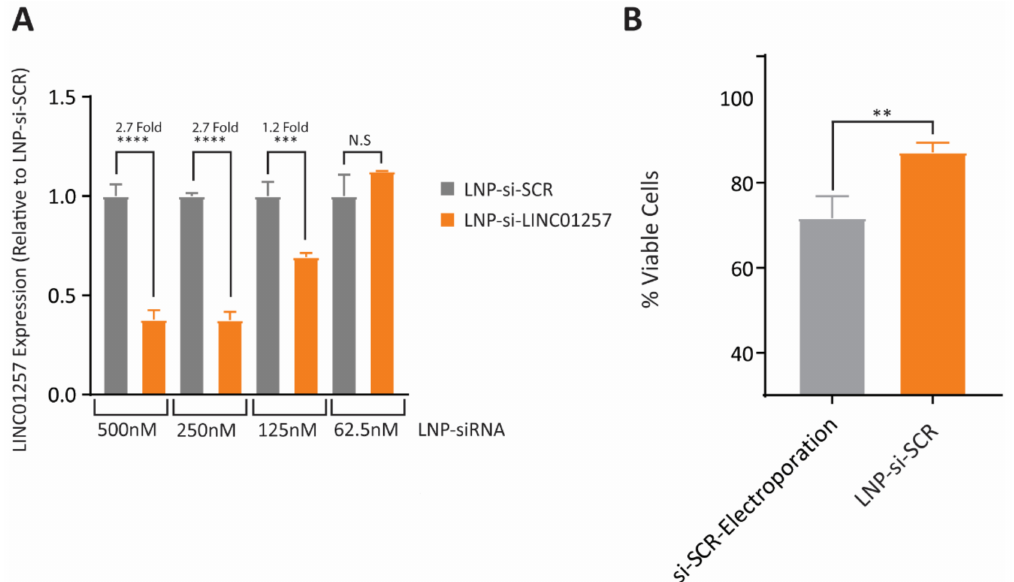
Figure 5. LNP-siRNAs can effectively target LINC01257 in Kasumi-1 cells. ( A ) RT-qPCR of LINC01257 expression following 72 h treatment with LNP-si-SCR at varying concentrations. **** = p < 0.0001, *** = p < 0.001, N.S = no significance. n = 3. ( B ) Viability of Kasumi-1 cells following either electroporation with si-SCR or 72 h LNP-si-SCR treatment. ** = p < 0.01. n =